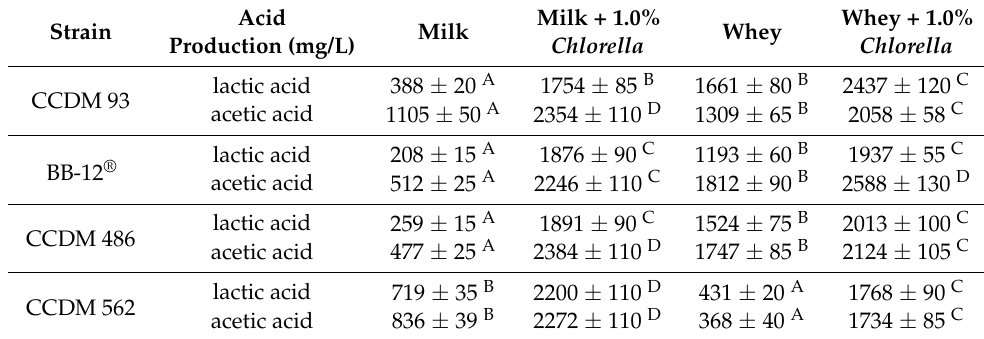
Table 2. Production of lactic acid and acetic acid after 24 h cultivation.